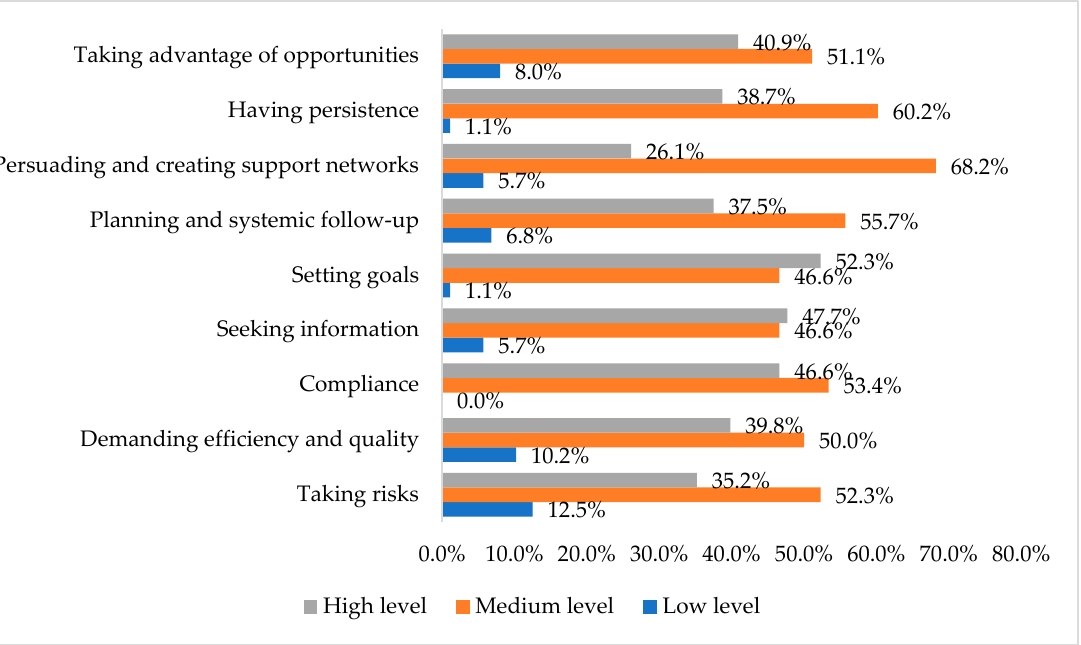
Figure 2. Personality traits and behavioural traits associated with pull entrepreneurial motivation, according to levels of perception. Source: authors.